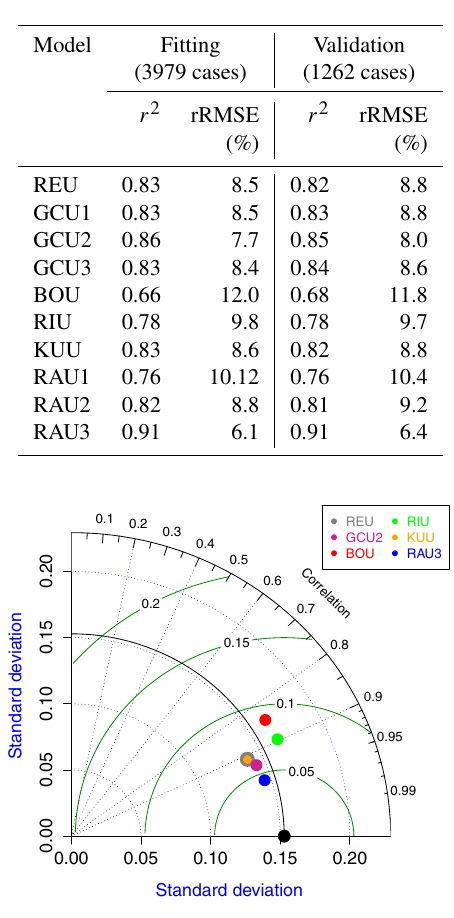
Table 1. Coefficient of determination and relative root-mean- squared error corresponding to the fitting against experimental mea- surements and the validation of each model.